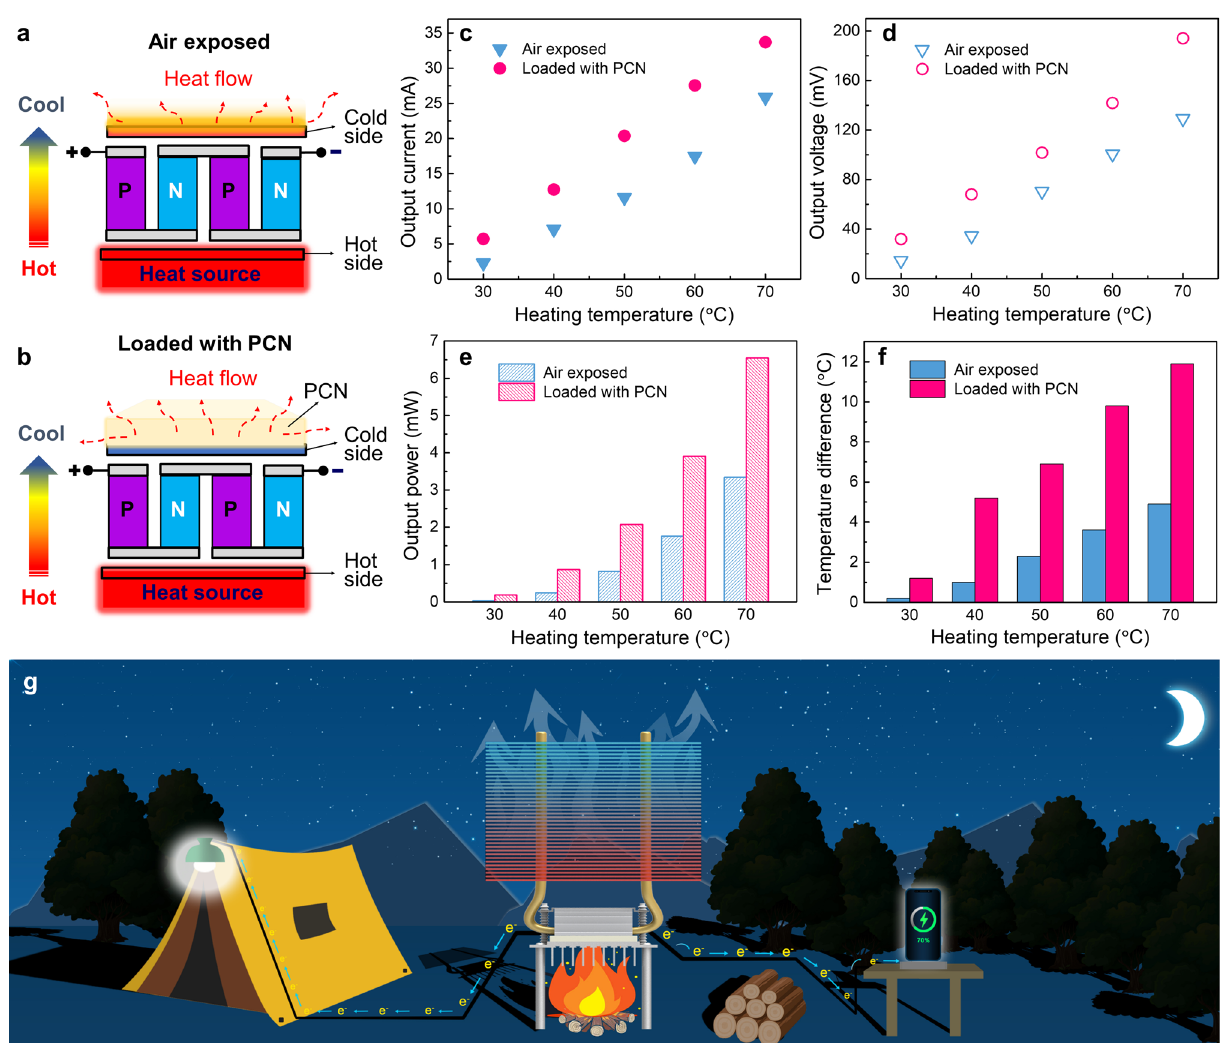
Fig. 6 Thermal management application of PEG@TPU/BNNS-es film (with 32 wt% BNNSs content) in thermoelectric generator (TEG). a Schematic mechanism of TEG exposed to air (top) and b loaded with PEG@TPU/BNNS-es (PCN) (bottom). c–e Output current, output voltage and output power of TEGs with/without PCC at different heating temperature, respectively. f Temperature difference between the hot and cold sides versus heating temperature of TEGs. g Conception diagram of potential application of TEGs integrated with the PEG@TPU/BNNS-es film for outdoor